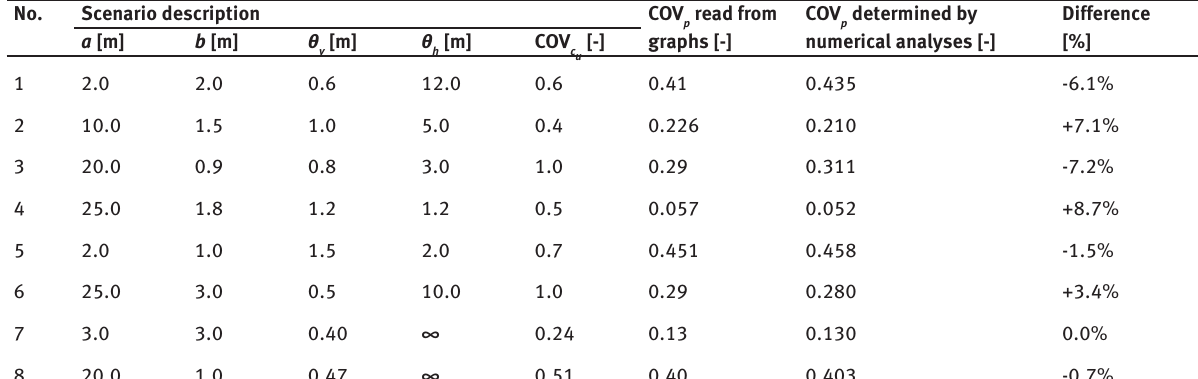
Table 2: Exemplary usage of the graphs proposed in this study. Detailed descriptions are in the text. No. Scenario description